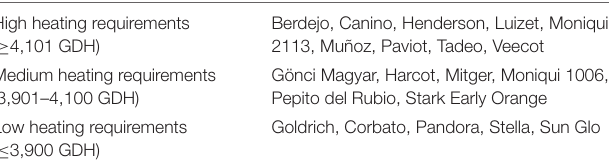
TABLE 4 | Classification of 20 apricot cultivars according to their heat requirements (growing degree hours) determined by the male meiosis method. High heating requirements Berdejo, Canino, Henderson, Luizet, Moniqui ( ≥ 4,101 GDH) 2113, Muñoz, Paviot, Tadeo, Veecot Medium heating requirements Gönci Magyar, Harcot, Mitger, Moniqui 1006, (3,901–4,100 GDH) Pepito del Rubio, Stark Early